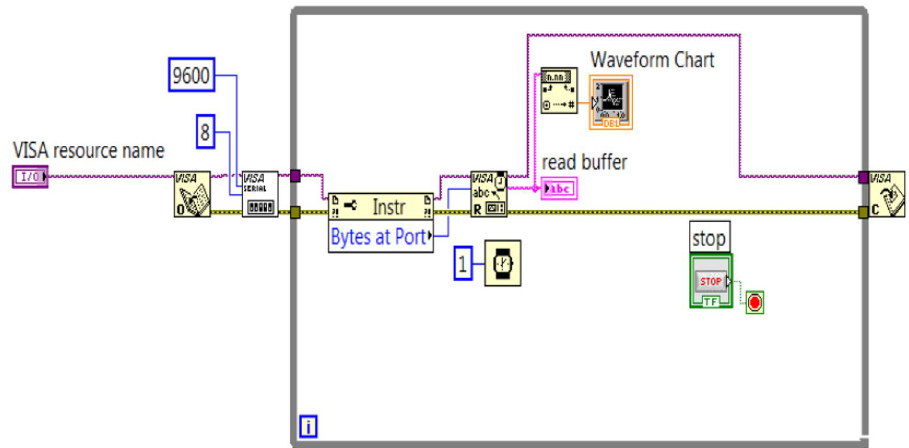
Fig. 8 Schematic of the Lab- VIEW block diagram